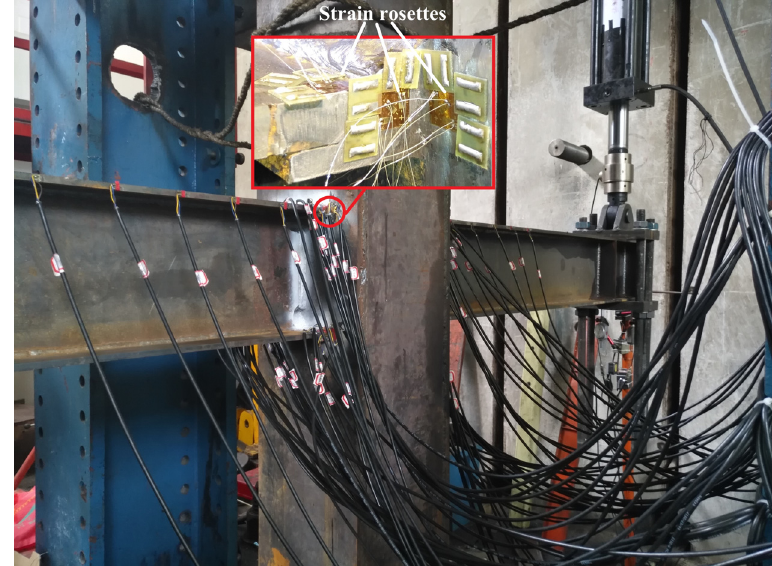
Figure 7. The location of strain rosettes in the specimen.